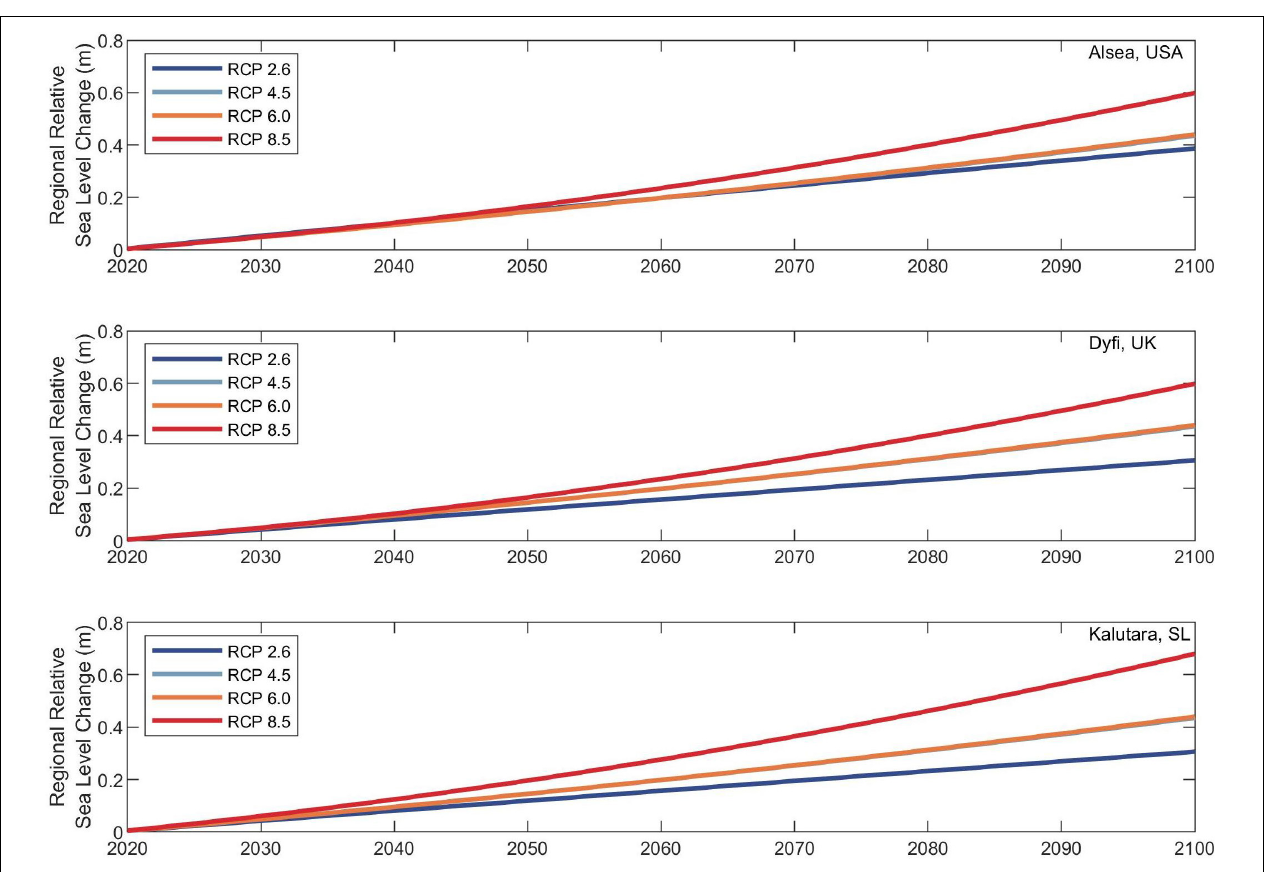
FIGURE 6 | Projected regional relative sea level at the selected barrier-estuary systems for different RCPs. The top , middle , and bottom sub-plots are corresponding to Alsea, Dyfi, and Kalutara inlets, respectively. Different colors indicate the four RCPs (see legend insert in each sub